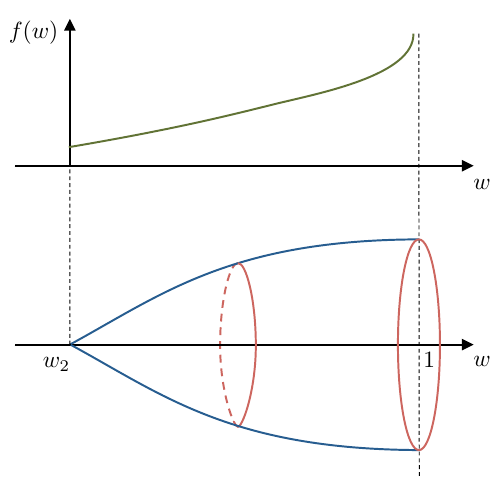
Figure 6. A schematic depiction of the internal geometry in Case II. The z circle is fibered over the w interval to yield Σ . In the metric ds 2 (Σ) in (2.1), Σ has the topology of a disk with a Z orbifold singularity at the center. We also depict the qualitative behavior of the AdS √ 1 − w 2 f ( w ) = 2 B w 3 / 5 /